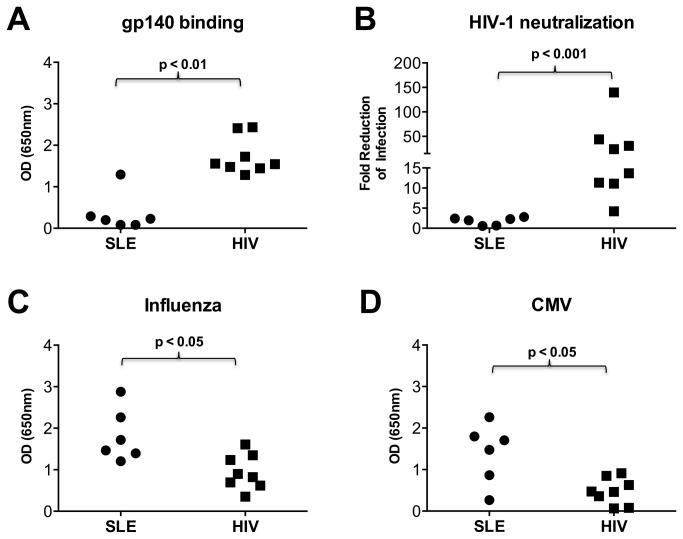
9G4+ antibodies purified from HIV- infected patients bind to HIV gp140 and neutralize HIV-1.9G4+ antibodies isolated from SLE patients (n=6) and PLWH (n=8) normalized to equal concentrations, were serially diluted in triplicate and added to ELISA plates coated with oligomeric YU2 gp140 (A) Influenza vaccine (C) or CMV lysate (D) and binding detected by anti-IgG. (B) 9G4+ antibodies were tested for inhibition of pseudotyped HIV-1 SF-162 infection of TZM-bl cells. Infectivity was measured by luciferase assay, and relative inhibitions were calculated after normalizing to internal controls. Each symbol represents the mean value of a patient. Significance determined by Mann-Whitney test.